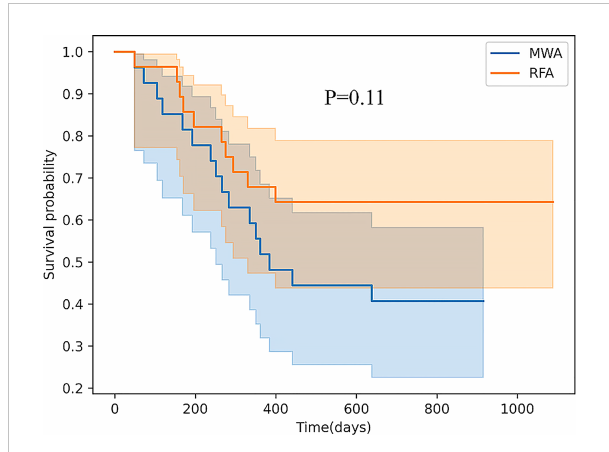
FIGURE 8 There was no difference in recurrence-free survival (RFS) between the RFA and WMA groups (P=0.11). The median survival time was 361 days for MWA and 460 days for